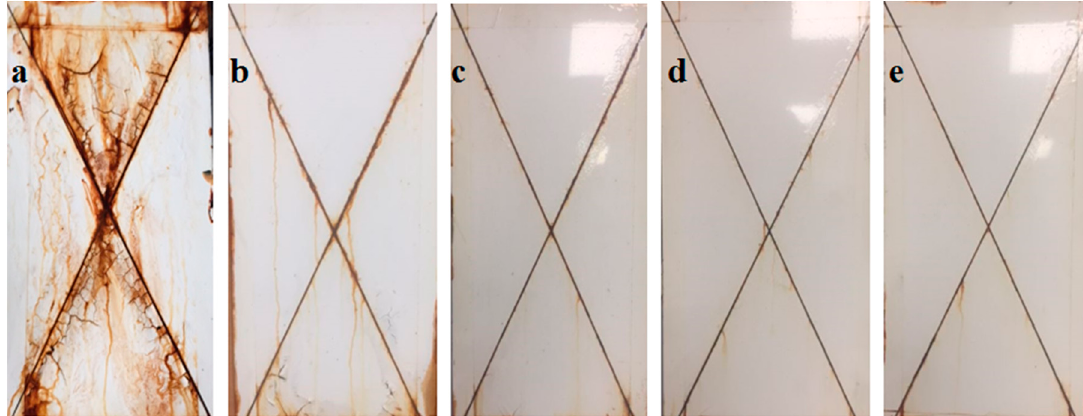
Figure 4. Salt spray test panels of the blank coating ( a ); reference material (RP) ( b ); 3 wt % cerium oxide microparticles (CER1) ( c ); 3 wt % cerium oxide nanoparticles (CER2) ( d ); 1 wt % cerium oxide nanoparticles (CER3) ( e ), after 672 h corrosion cycles under 5% NaCl solution.